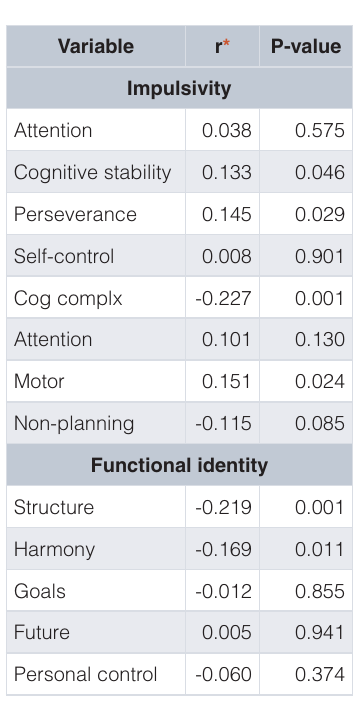
Table 3. Association of ACE scores with subscales of impulsivity and functional identity